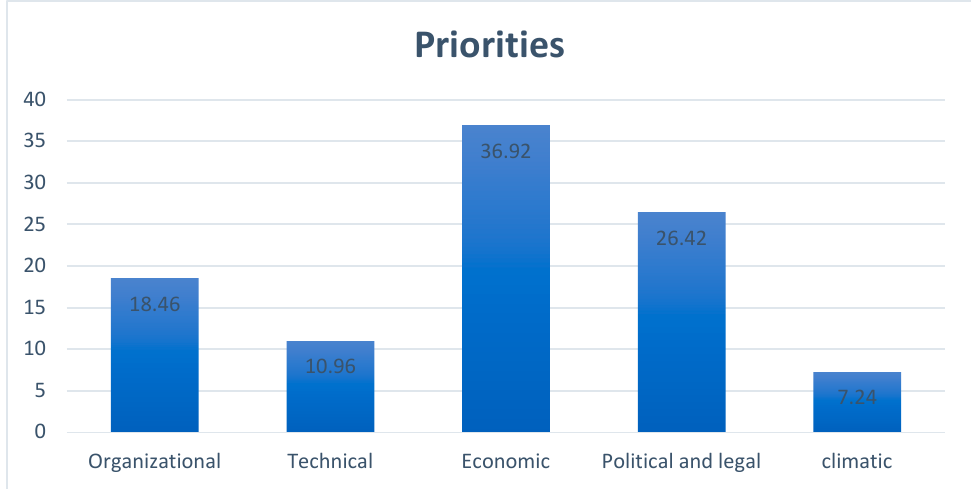
Figure 5. Priorities (relative importance) of the main groups of factors.